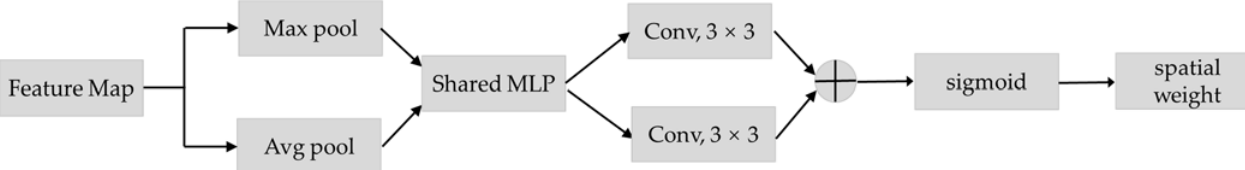
Figure 8. Illustration of the SAM module: shared MLP refers to the multi ‐ layer perception structure. Max pool and avg pool stands for max ‐ pooling and average pooling, respectively. Sigmoid refers to the sigmoid activation function.